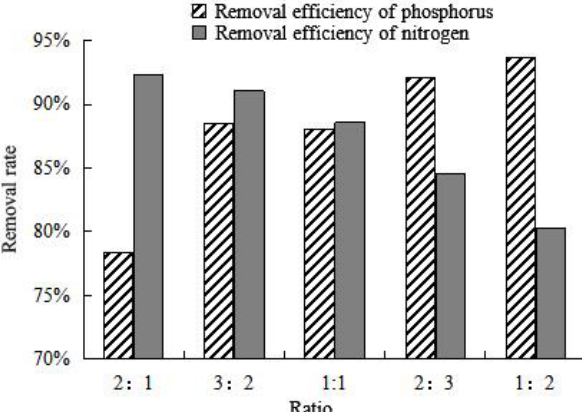
Figure 9. Column chart of adsorption efficiency of different proportions of thermally modified zeolite and diatomite on nitrogen and phosphorus.